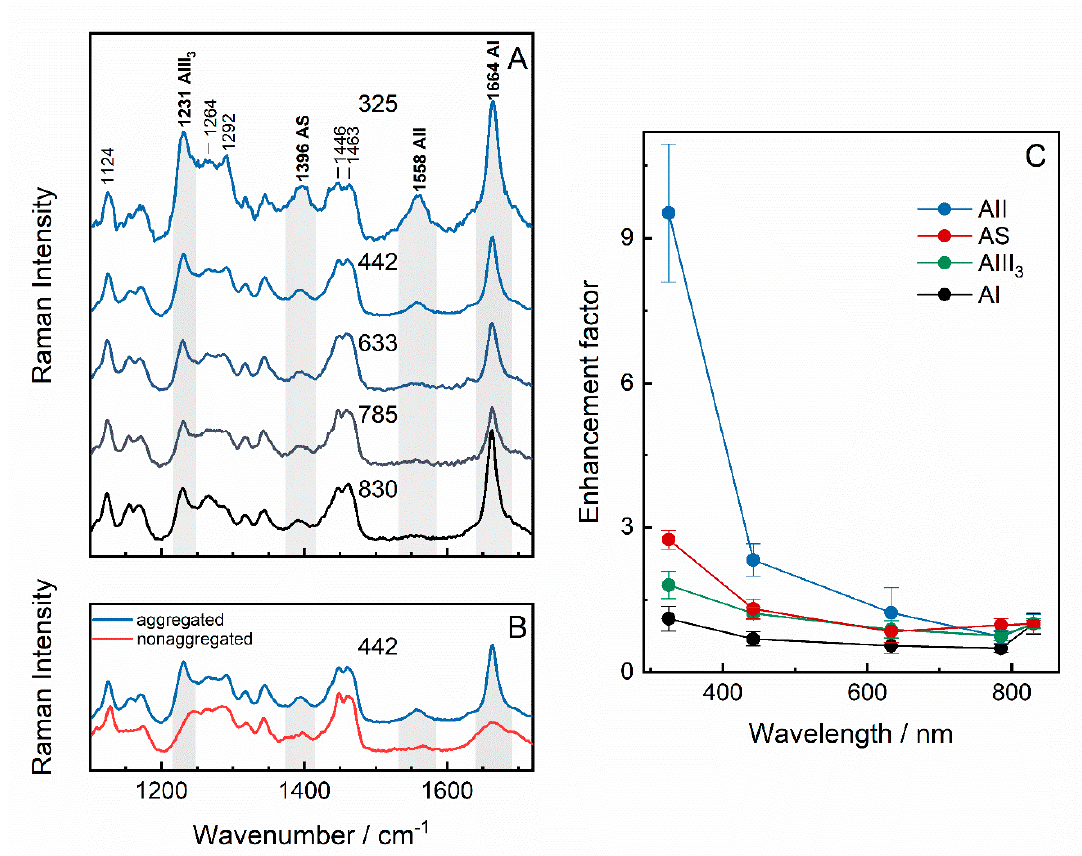
Figure 2. Raman spectra of aggregated (20 gm / mL) GGVVIA peptide in H 2 O excited at 325, 442, 633, 785, and 830 nm ( A ) and Raman spectra of aggregated and non-aggregated (5 mg / mL) GGVVIA in H 2 O excited at 442 nm. Spectra are normalized with respect to the peak intensity at 1463 cm − 1 ; the spectral intensity is retained in both ( A ) and ( B ) panels. The ( C ) panel shows the dependence of the enhancement factor of AII, AS, AI, and AIII 3 bands on the excitation wavelengths.